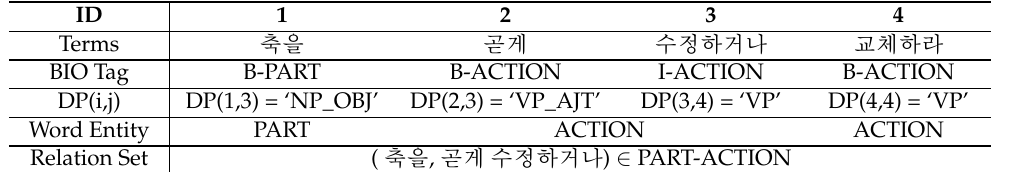
Table 5. An example of the results of applying Rule